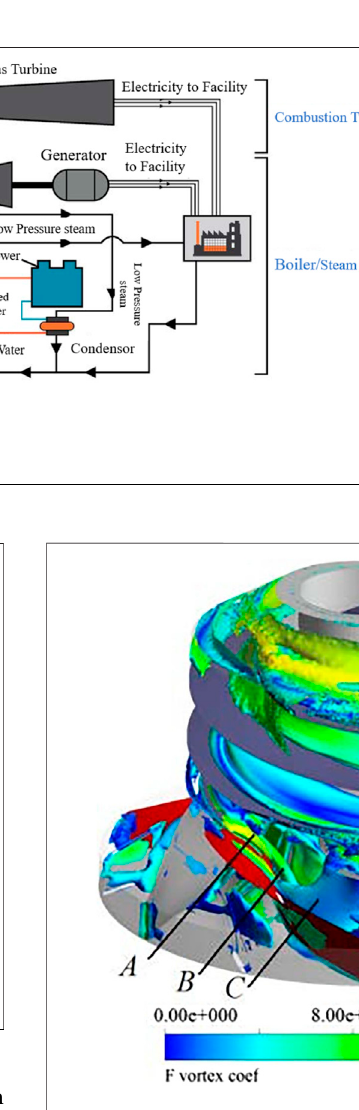
FIGURE 3 | Vortex core in the inducer-impeller (Zhao J,